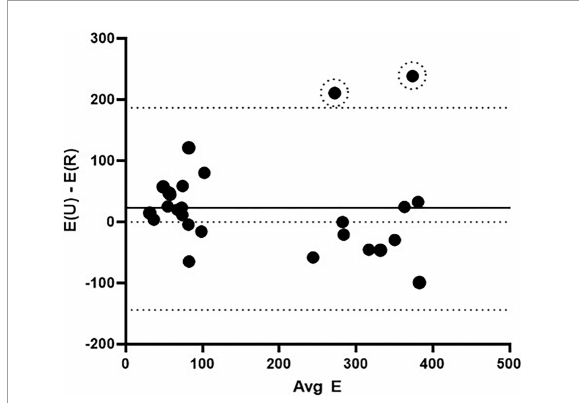
FIGURE5 Bland-Altman agreement analysis between the radial and uniaxial methods for determining elastic modulus. The solid middle line indicates the bias and the bounding dashed lines indicate the limits of agreement ( ± 1.96 SD). Data included are YU PA, YU PV, YO PA elastic modulus in the elastic and fibrous regimes ( N = 30). Two outliers are noted by dashed circles. E(U) – E(R) = the difference in Young’s modulus values between the uniaxial and radial testing methods, and Avg E = the averaged Young’s modulus values for the two methods for a given stress.